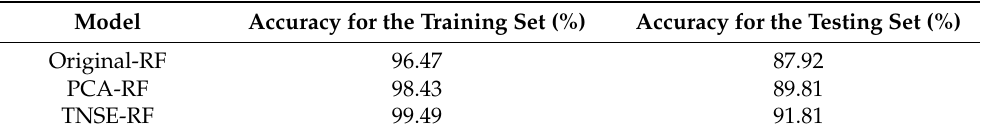
Table 4. The classification results for the training and testing sets based on RF models (100 times).